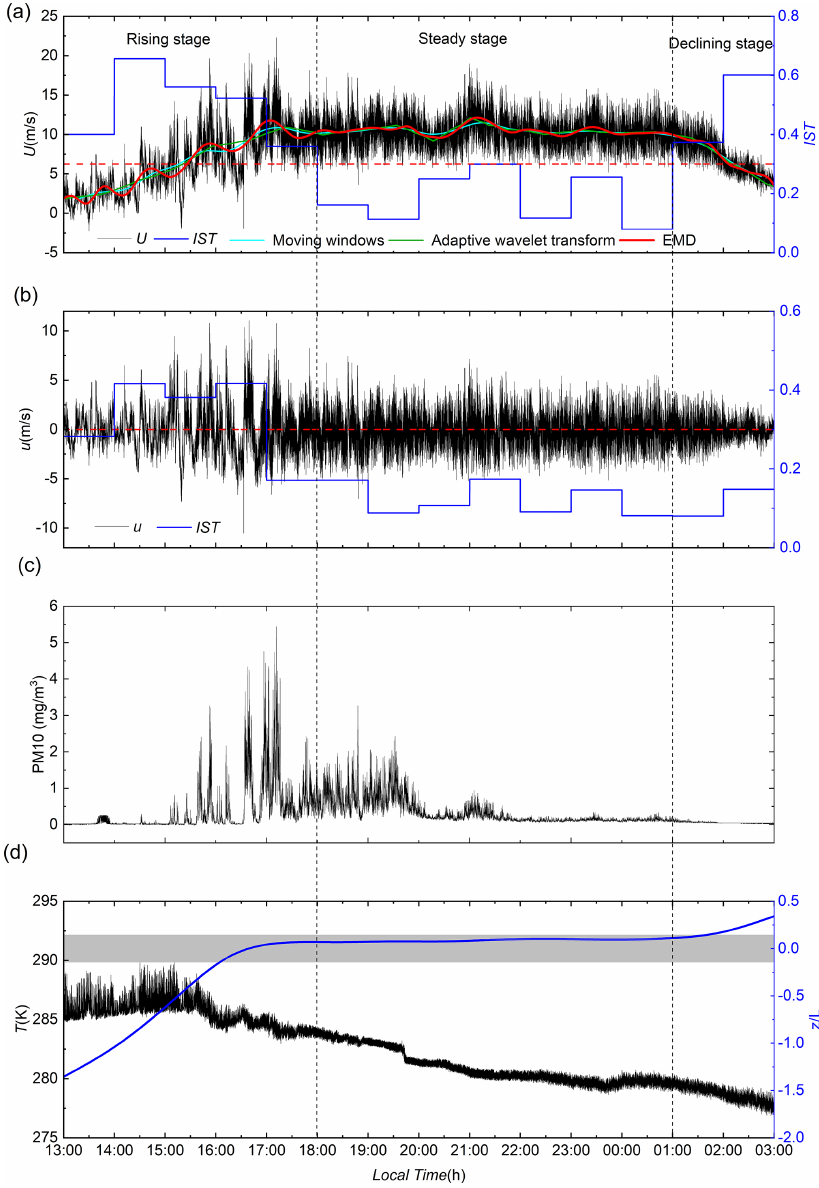
Figure 2. (a) Streamwise velocity time series during the whole process of the sandstorm: the red line, cyan line, and green line are the time-varying average velocities obtained by EMD, moving average, and adaptive wavelet transform, respectively; the blue line is the non- stationary index IST. (b) The fluctuating streamwise velocity signal resulting from removing the trend term in (a) . (c) The concentration of PM 10 . (d) The temperature and z/L , where the shaded area marks the near-neutral stratification condition of | z/L | < 0 .